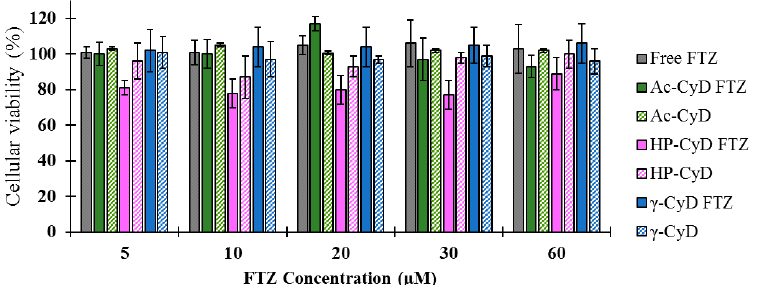
Figure 4. Cellular viability of A549 cells, 72 h after incubation with FTZ in the free form (Free FTZ), incorporated in CyD (Ac-CyD FTZ; HP-CyD FTZ; ϒ -CyD FTZ) or in unloaded CyD (Ac-CyD; HP-CyD; ϒ -CyD). FTZ tested concentrations ranged from 5 to 60 µM. Unloaded CyD were also used as control using the same amount as the ones used for the respective FTZ CyD complex. The obtained results are expressed as a mean ± SD of sextuplicate values for each concentration and formulation tested.